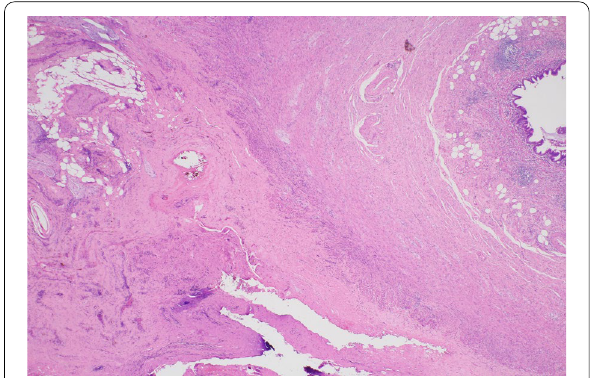
Fig. 5 Histological findings of the appendix. The appendiceal mucosa is relatively normal, and the serosal side shows thickened fibrotic changes. Hemosiderin deposition is seen on the mesenteric surface, suggesting chronic inflammatory changes. There are no signs of perforation